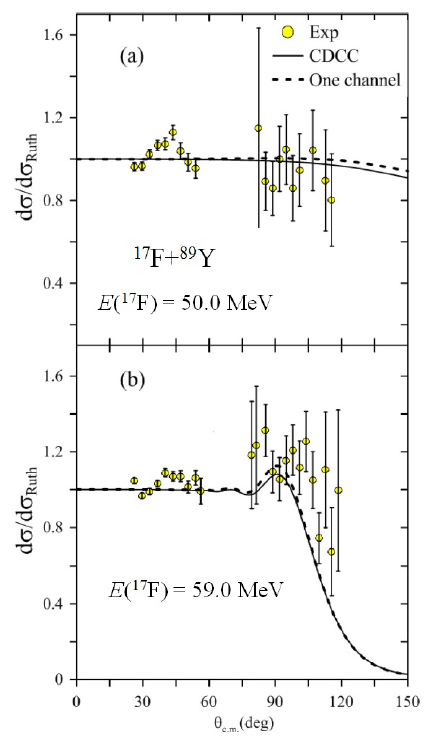
Figure 3. Angular distributions of elastic scattering of 17 F on 89 Y at E 17 F) = 50.0 (a) and 59.0 (b) MeV [18]. The solid and lab ( dashed curves represent the CDCC and one-channel